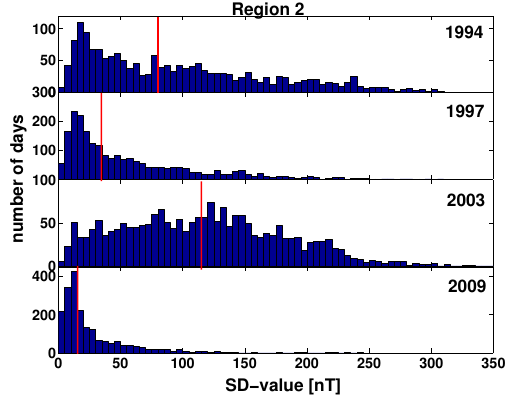
Figure 4. Yearly distributions of daily SD values of ground mag- netic X component in Region 2 during active (1994 and 2003) and quiet years (1997 and 2009). Note that the scale of Y axis varies from year to year. The red vertical lines show the median values of the distributions At Region 2 latitudes (Fig. 4), the difference between the 2 minimum years is much more pronounced than in Region 1.